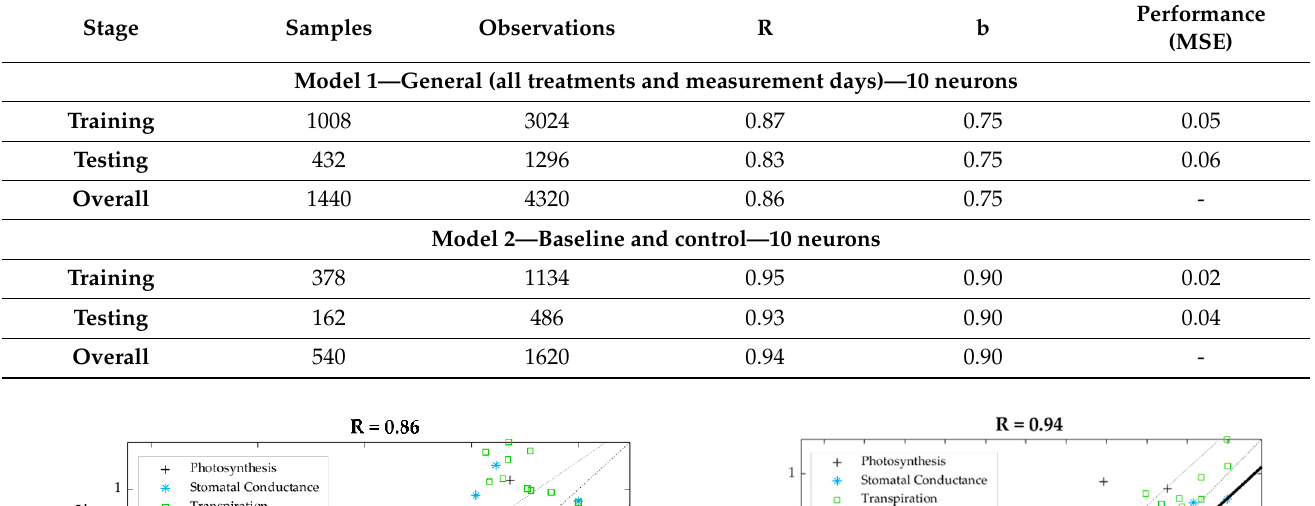
Table 2. Machine learning regression models based on artificial neural networks (Bayesian Regularization) to predict physiological data using the electronic nose outputs as inputs. Abbreviations: R: correlation coefficient; b: slope; MSE: means squared error.